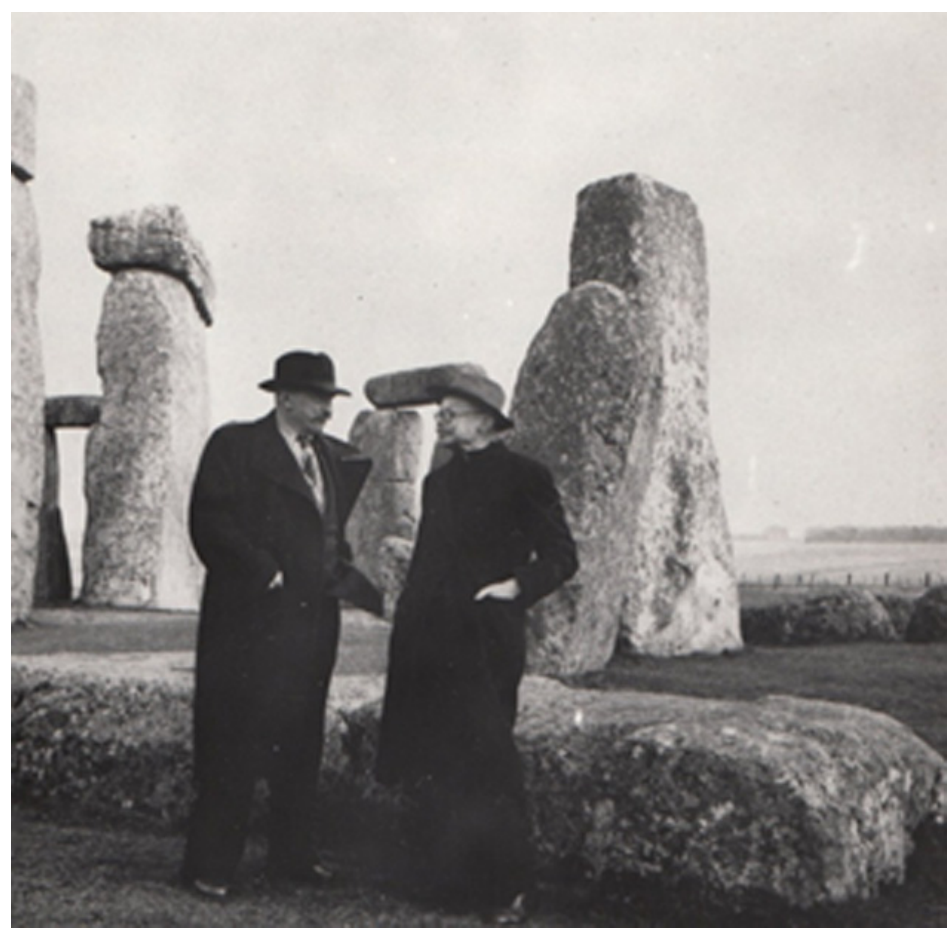
Fig. 2: Gordon Childe and a Russian archaeologist at